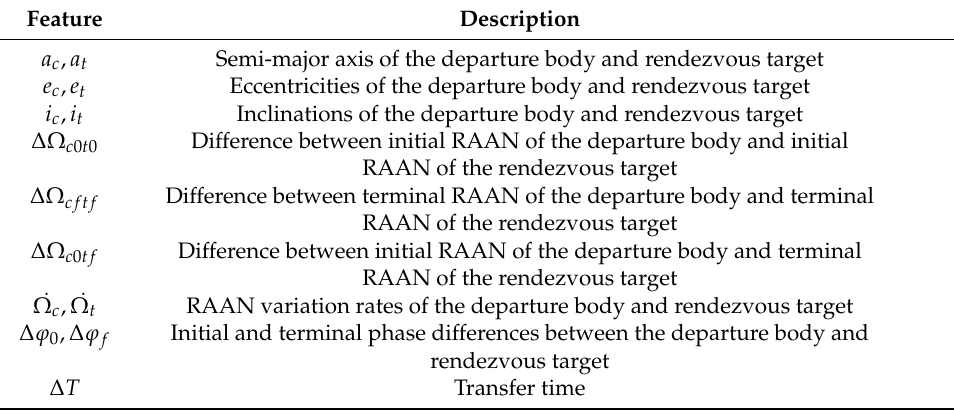
Table 3. Potential learning features for estimating optimal velocity increments.